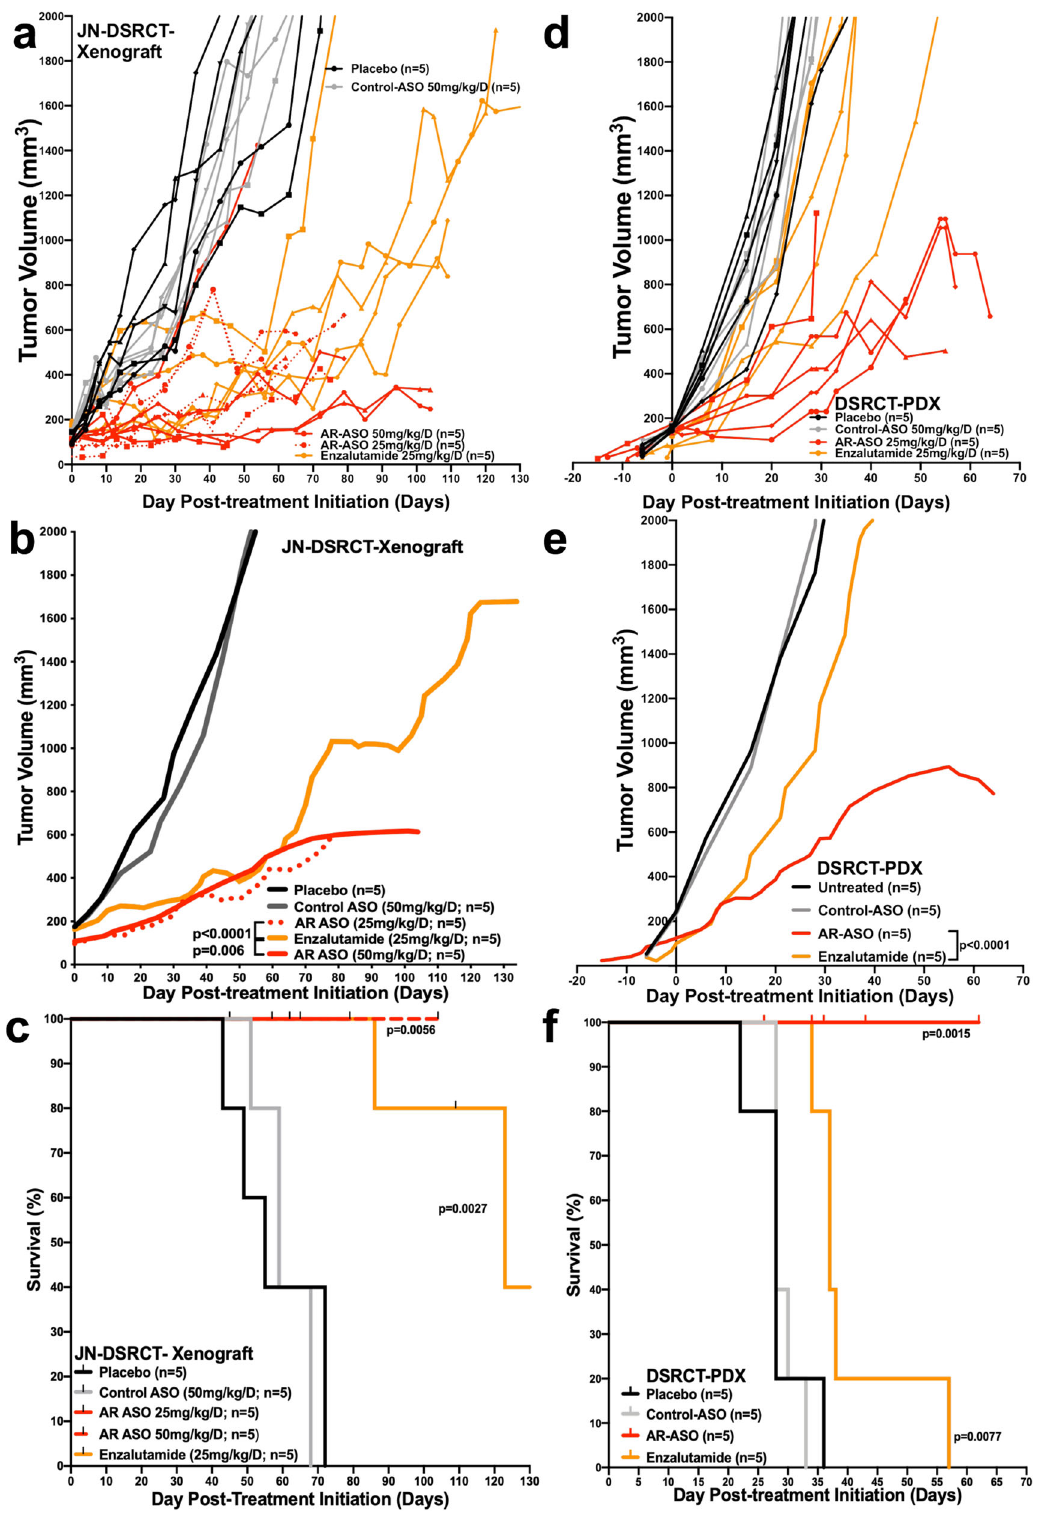
Fig. 5 Preclinical ef fi cacy of AR antisense-based therapy for the treatment of DSRCT. a – c Therapeutic effect of AR blockade in JN-DSRCT xenografts done in three replicates. Tumor-bearing mice volumes and survival were reported after treatment with enzalutamide (25 mg/kg, orange), AR-ASO (25 mg/kg, regular red; 50 mg/kg, dotted red), control ASO (gray), or placebo (black). The top panel ( a ) shows the individual data for each mouse; the middle panel ( b ) shows a smoothed grouped median of relative tumor volumes; the lower panel ( c ) shows the survival Kaplan – Meier curves of each treated group of mice. d – f Similar data is shown for a DSRCT PDX treated with the same agents. d Individual PDX data, e smoothed PDX data, and f Kaplan – Meier curves for the DSRCT PDX. P values reported for the smoothed tumor growth curves ( b and e ) were calculated by a two-tailed unpaired t - test. Kaplan – Meier P values were calculated by the log-rank (Mantel – Cox) test. n is the number of mice treated in each treatment group.